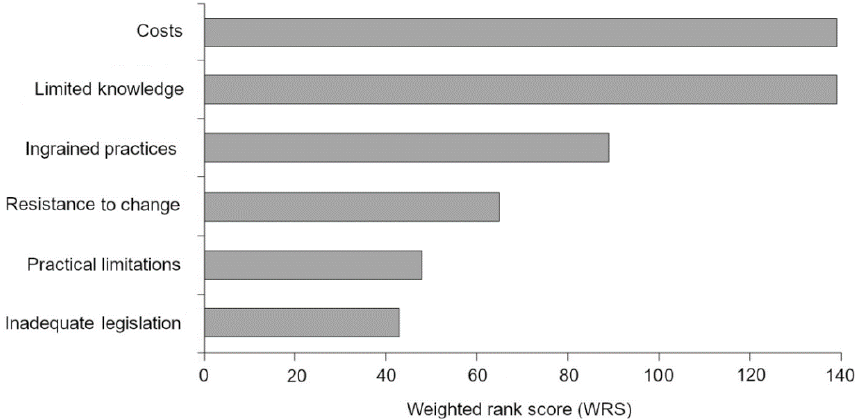
Figure 6. Veterinarians’ perceived barriers to welfare-related change, based on coded qualitative responses. The WRS takes into account the frequency of the code and its weighted rank to ensure the greatest concerns had a proportional representation. For each code, the WRS was calculated as the sum of the number of occurrences of the code at each rank, multiplied by the rank’s weight constant. A higher WRS indicates greater concern among veterinarians.